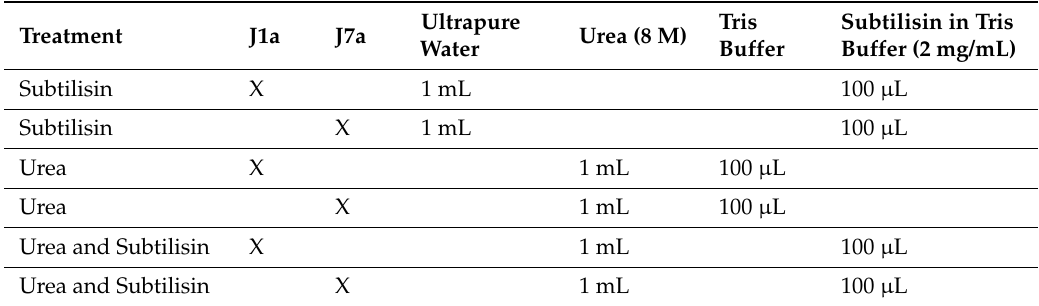
Table 2. Sample preparation for the subtilisin and urea treatments. J1a (black currant juice) and J7a (sea buckthorn juice) refers to the dried residue of 500 µ L of pure juice. Ultrapure Treatment J1a J7a